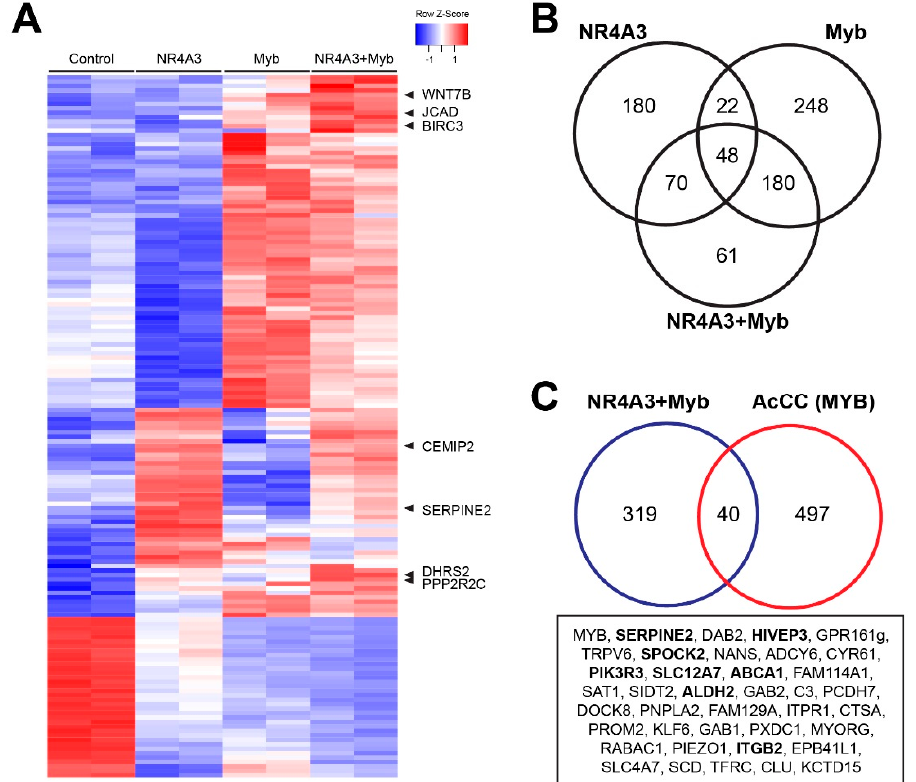
Figure 5. Differential gene expression induced by NR4A3 and Myb overexpression. ( A ) NCI-H292 mucoepidermoid cells were transduced with control (none), NR4A3, Myb or NR4A3 plus Myb. After 48 h, total RNA was isolated and RNA-seq analysis was performed. The heatmap summarizes the most significant differences in gene expression. Up- and downregulated genes are indicated by red and blue, respectively, as indicated in the key. Figure S6 has a larger version of this heatmap with all genes labeled; ( B ) Venn diagram comparing genes commonly regulated between NR4A3, Myb and NR4A3 plus Myb; ( C ) Venn diagram comparing genes commonly regulated by NR4A3 plus Myb vs. poor survivor subgroup of AcCC overexpressing NR4A3 plus MYB . We identified 40 genes commonly regulated in both sets, which are listed in the box below the Venn diagram.